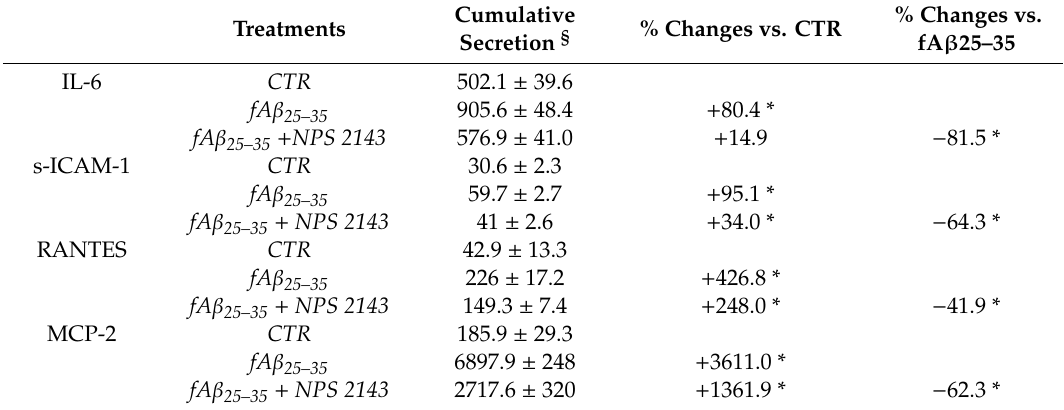
Table 2. Impact of calcilytic NPS 2143 on fA β 25–35 -evoked cumulative 0-h-to-96-h secretion / shedding of neuroinflammatory agents from